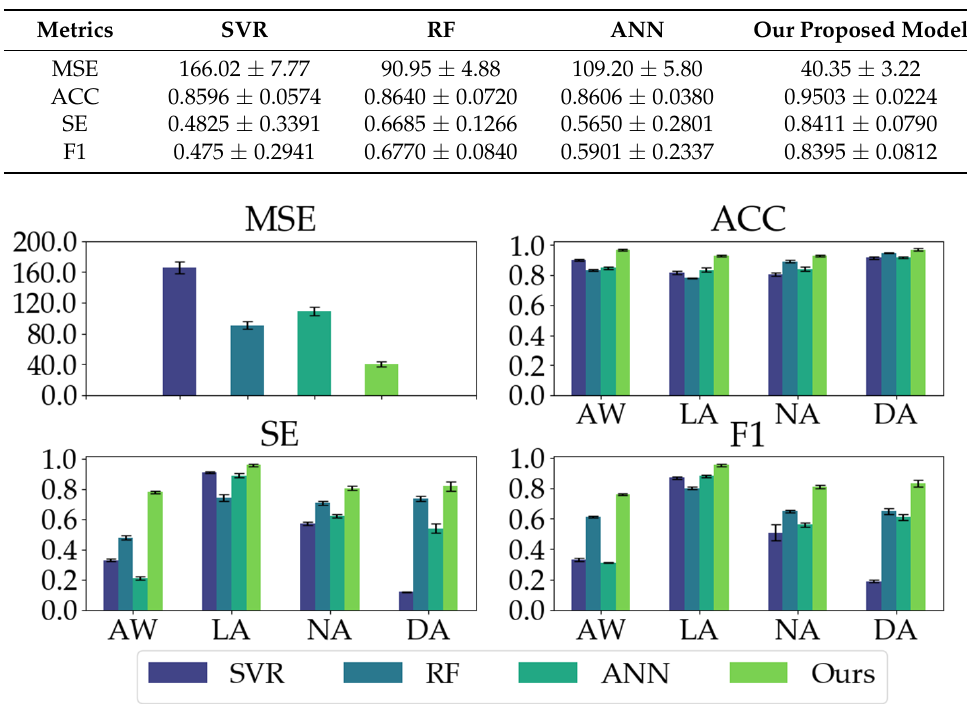
Table 2. The regression and classification results (mean ± STD) of our proposed model and three conventional models. The mean squared error (MSE) result is the average of the five-fold cross- validation where we split all the samples into five groups, four groups are used as the train set, and one group is used as the test set for each cross-validation. The accuracy (ACC), sensitivity (SE), and F1-score (F1) results are the macro-averaging (we compute the metrics independently for each anesthetized state and then take the average) results of the 4 different anesthetized states.